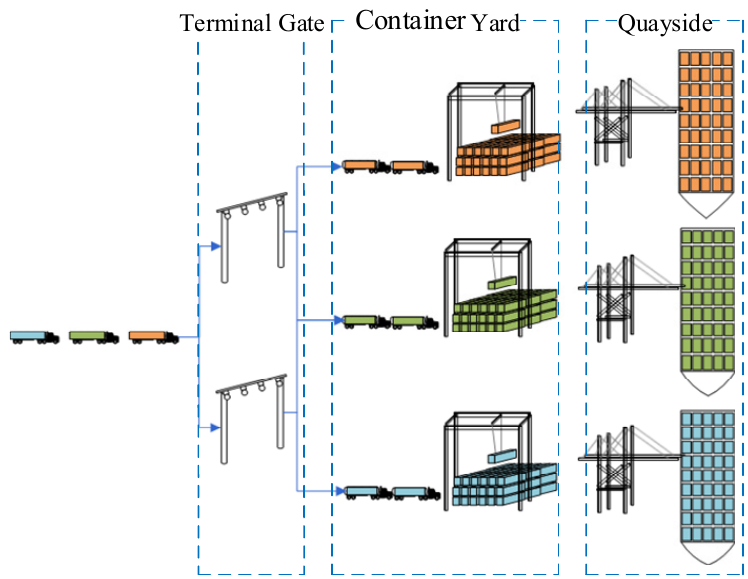
Figure 1. The process of outbound container delivery.